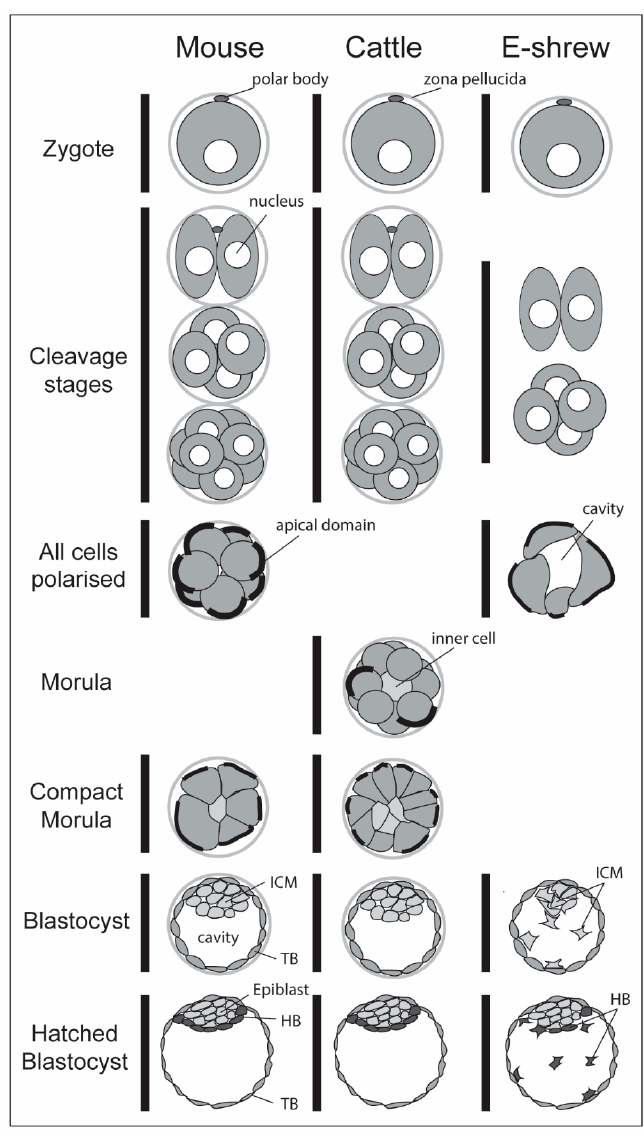
Figure 2. Main developmental stages in an Euarchontoglirian (mouse), Laurasiatherian (cattle) and Afrotherian (elephant shrew). While the sequence of morphological events is largely conserved, some species lack certain stages: mouse embryos compact already at the 8-cell (cleavage) stage, thus skipping the un-compacted morula stage; cattle embryos do not pass through a stage where all blastomeres are polarised and elephant shrews miss out on morula stages altogether and lose their zona pellucida prematurely, immediately after the 1-cell stage. The cattle sequence also applies to the Euarchontoglirian rabbit and human embryo. HB; hypoblast; ICM, inner cell mass; TB, trophoblast.